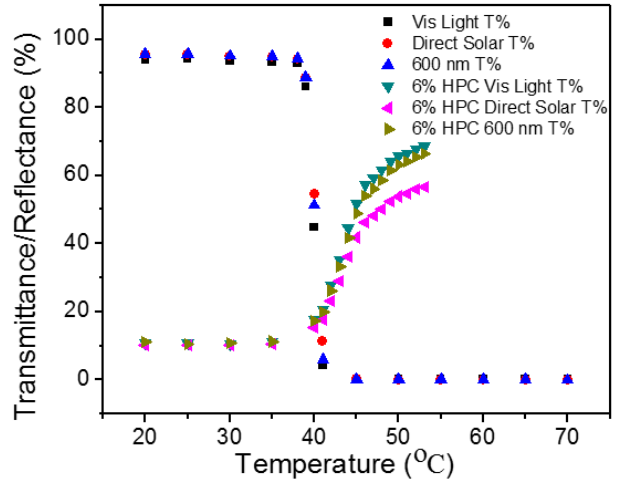
Figure 10. Measured transmittance and reflectance data for aqueous 6 wt. % HPC at 600 nm, Vis Light